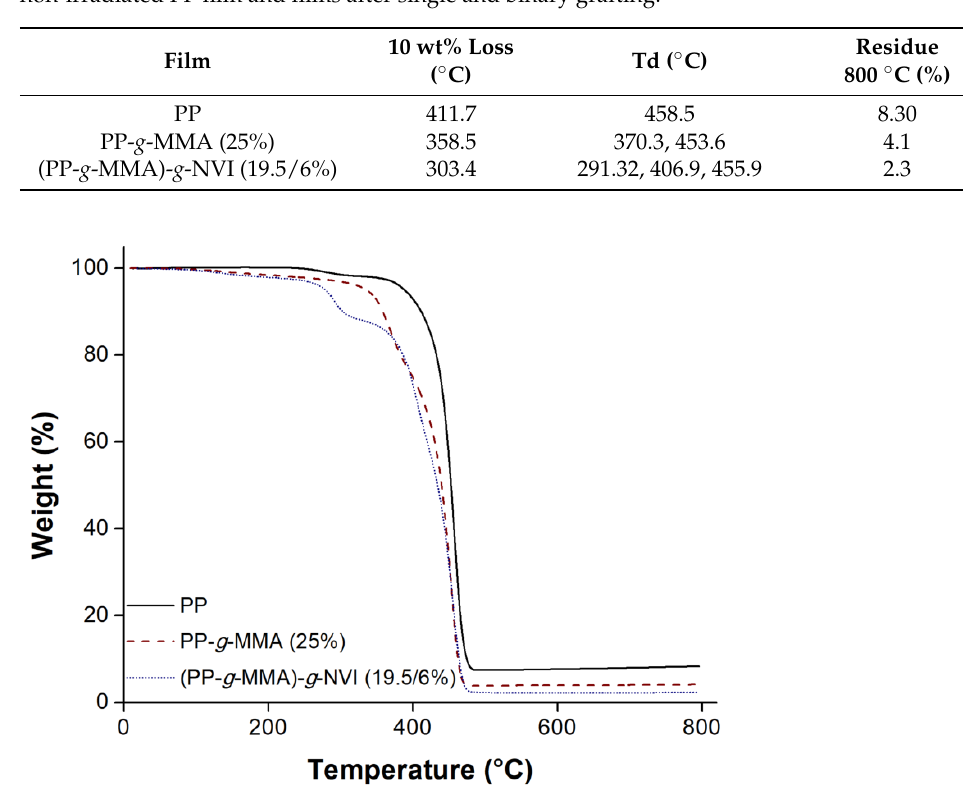
Figure 6. Thermogram runs under nitrogen atmosphere at 800 °C and heating rate 10 °C min −1